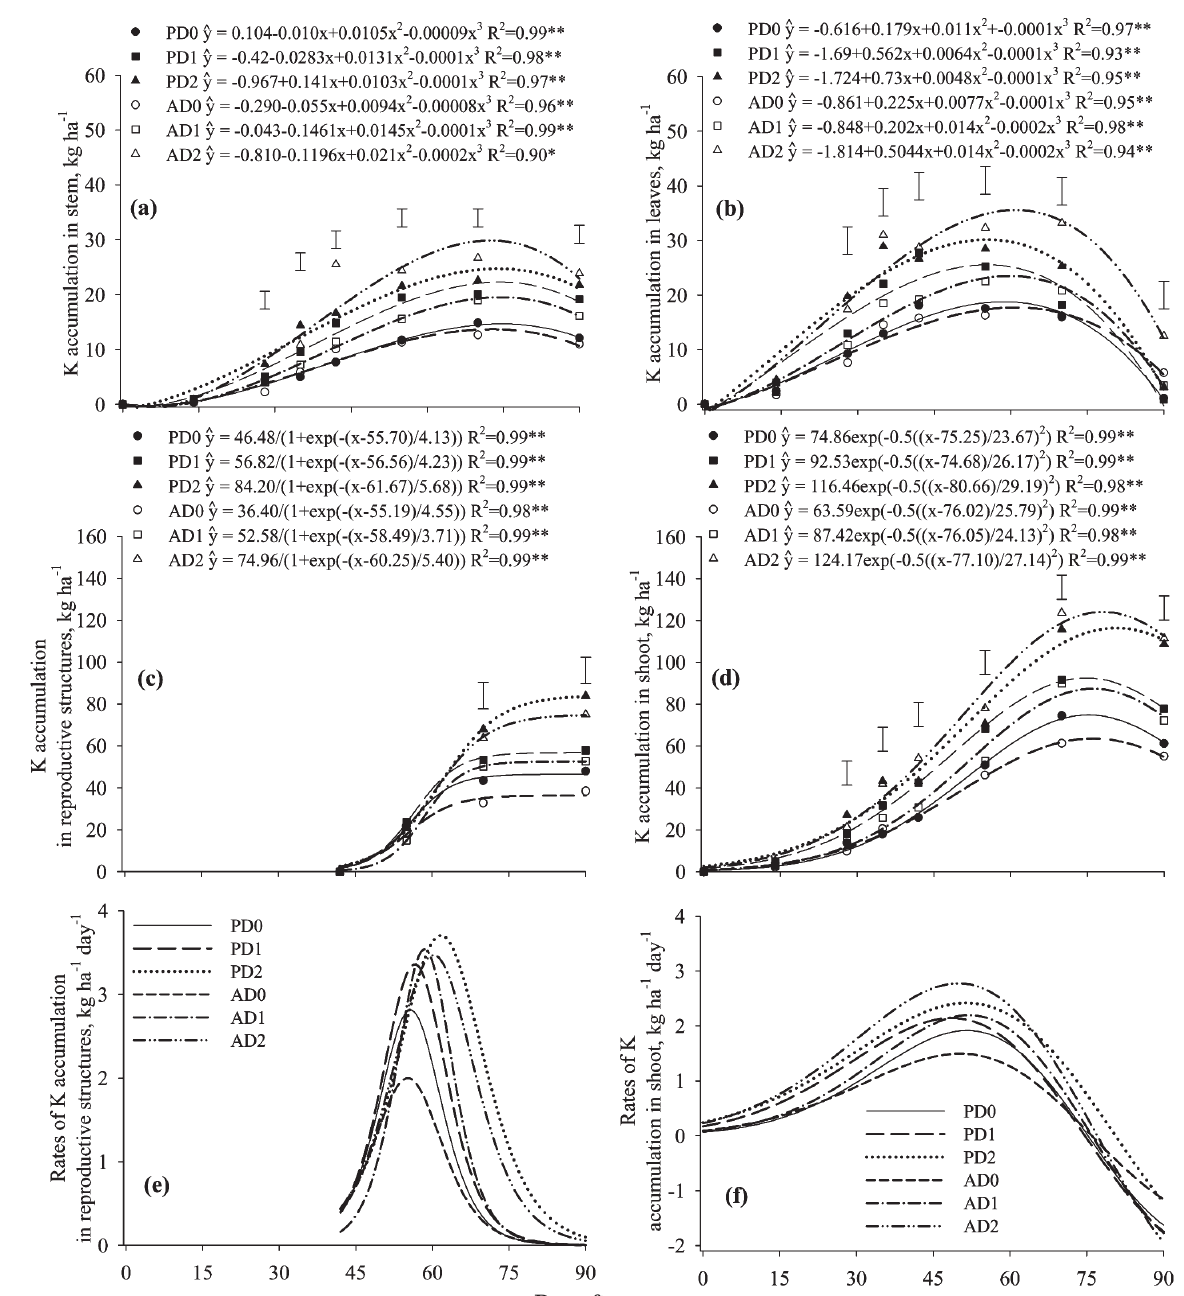
Figure 4. Potassium accumulation in stem (a), leaves (b), reproductive structures (c), and shoot (d) and rates of accumulation of K in reproductive structures (e) and shoot (f) of common bean cultivars, under different levels of fertilization. ** and * are: significant at p 0.01 and p 0.05 by the F test. Vertical bars represent the Least Significant Difference (LSD) at p 0.05. PD0 = Pérola without NPK fertilization, PD1 = Pérola with 50 % of recommended NPK fertilization; PD2 = Pérola with 100 % of recommended NPK fertilization; AD0 = IAC Alvorada without NPK fertilization, AD1 = IAC Alvorada with 50 % of recommended NPK fertilization; AD2 = IAC Alvorada with 100 % of recommended NPK